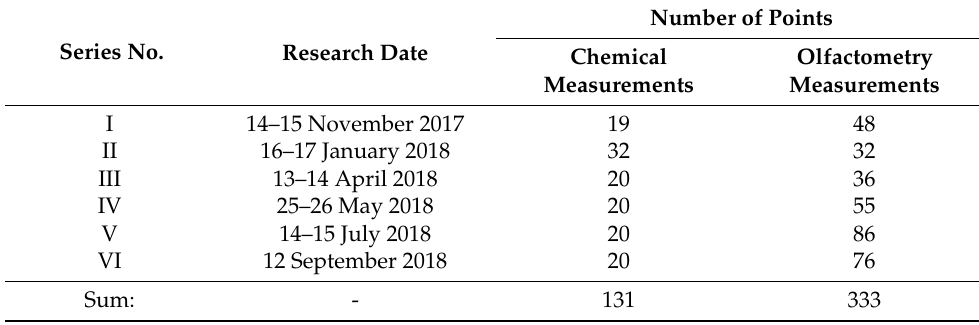
Table 2. Schedule of chemical and olfactometric tests with the number of receptor points.